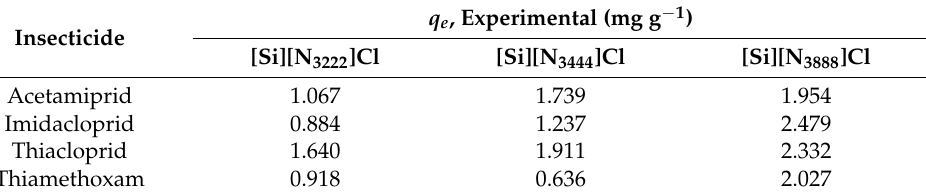
Table 2. Experimental equilibrium concentration of the adsorbate in the solid phase ( q e , experimental) of acetamiprid, imidacloprid, thiacloprid, and thiamethoxam for [Si][N 3222 ]Cl, [Si][N 3444 ]Cl, and [Si][N 3888 ]Cl. q e , Experimental (mg g − 1 ) Insecticide